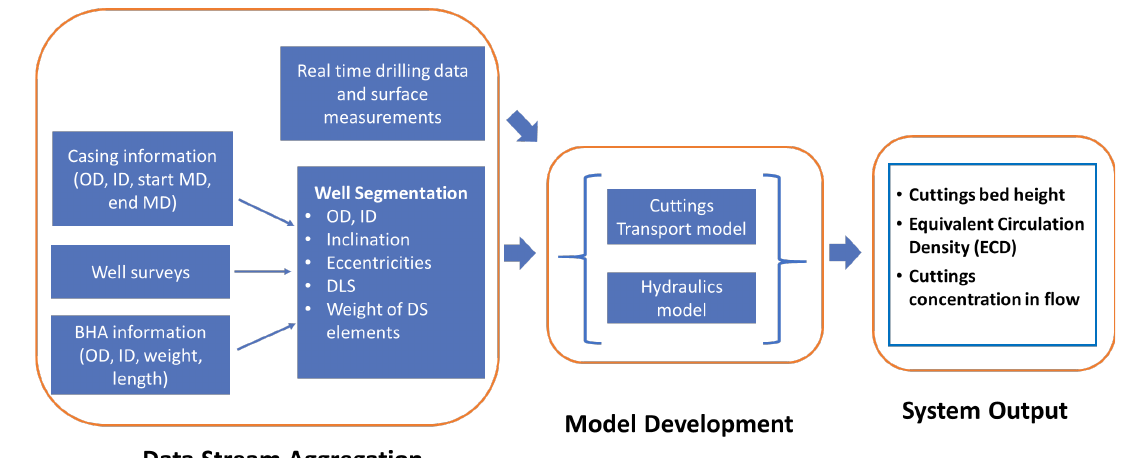
Figure 4. The developed variant of the digital twin for the hole cleaning system, see also [82].